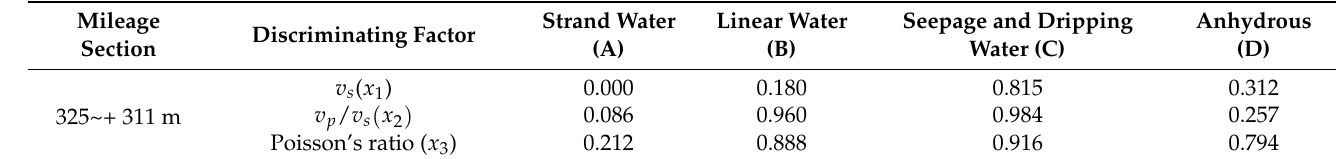
Table 2. Membership degree of TSP identification factors to fuzzy sets.